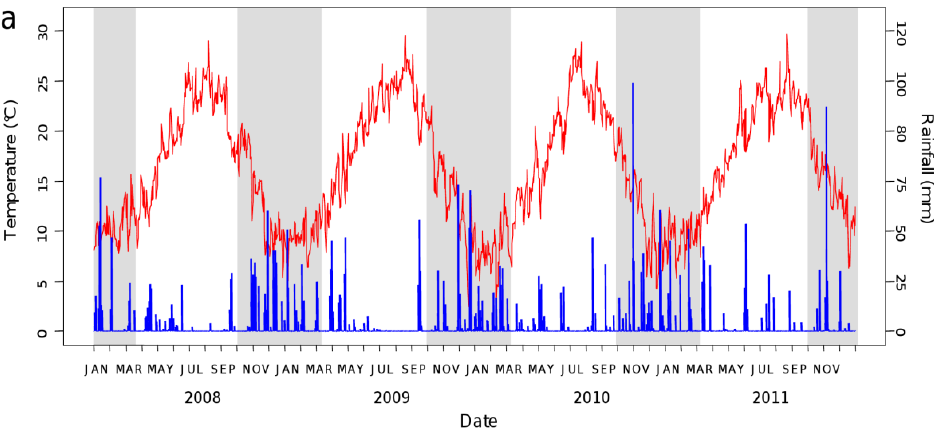
Figure 3. Aedes albopictus population dynamics simulated over four years according to temperatures and rainfall, Nice region, 2008–2011. ( a ) Daily mean temperature (red) and rainfall (blue). ( b ) Simulated number of individuals in the aquatic stages (eggs, larvae and pupae). ( c ) Simulated number of individuals in the aerial stages ( A : nulliparous host-seeking; 1h A : nulliparous engorged; A : nulliparous seeking oviposition site; A : parous 1g 1o 2h host-seeking; A : parous engorged; A : parous seeking oviposition site). The 2g 2o